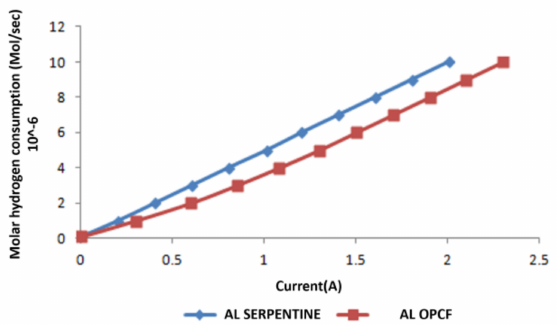
Figure 8. Hydrogen consumption (Al bipolar plate material).